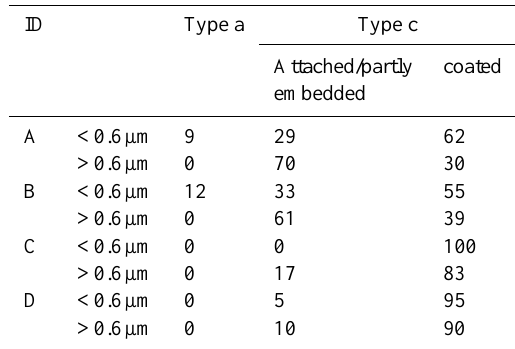
Table 4. Number fraction of mixing type of soot for soot-containing particles